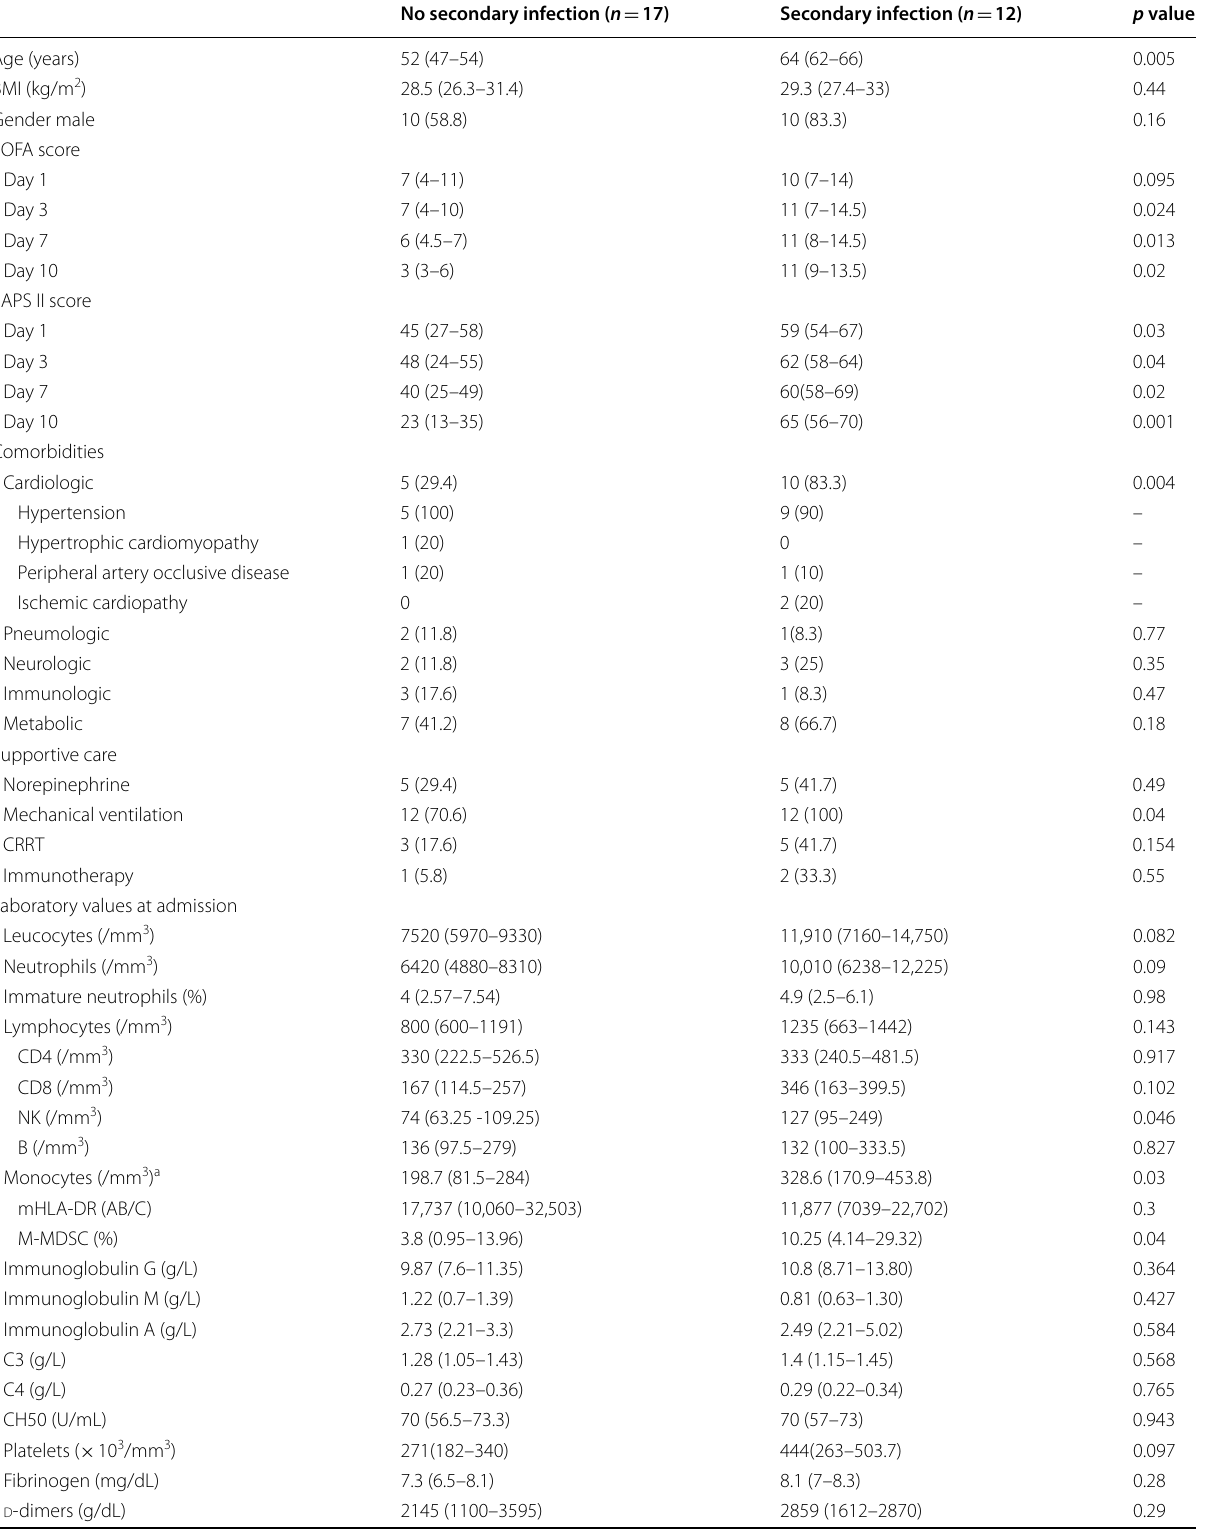
Table 1 Patients